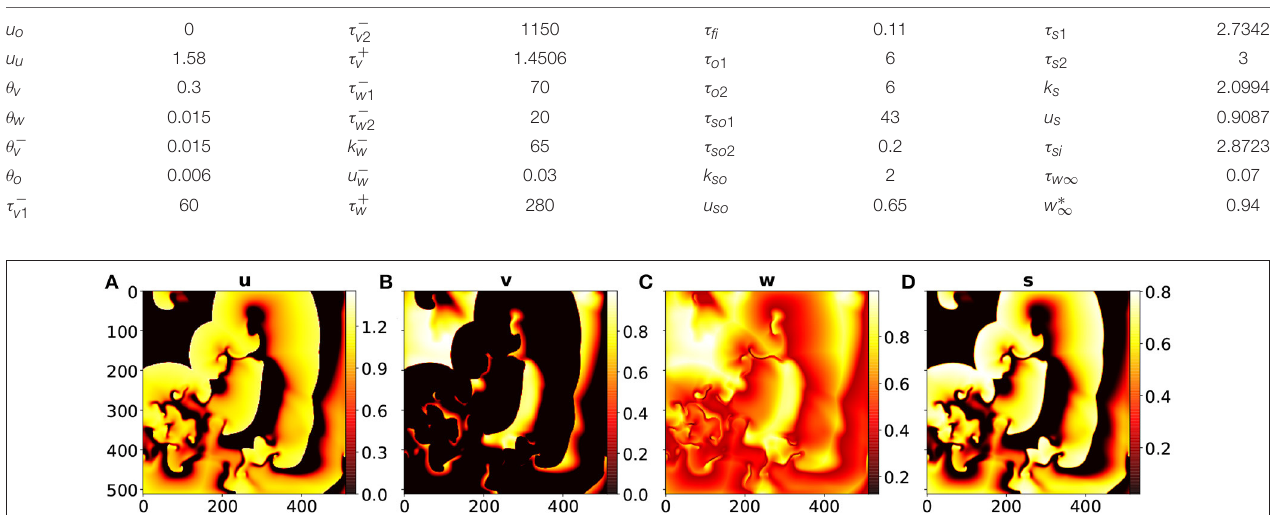
TABLE 1 | TNNP model parameter values for the BOCF model [11].